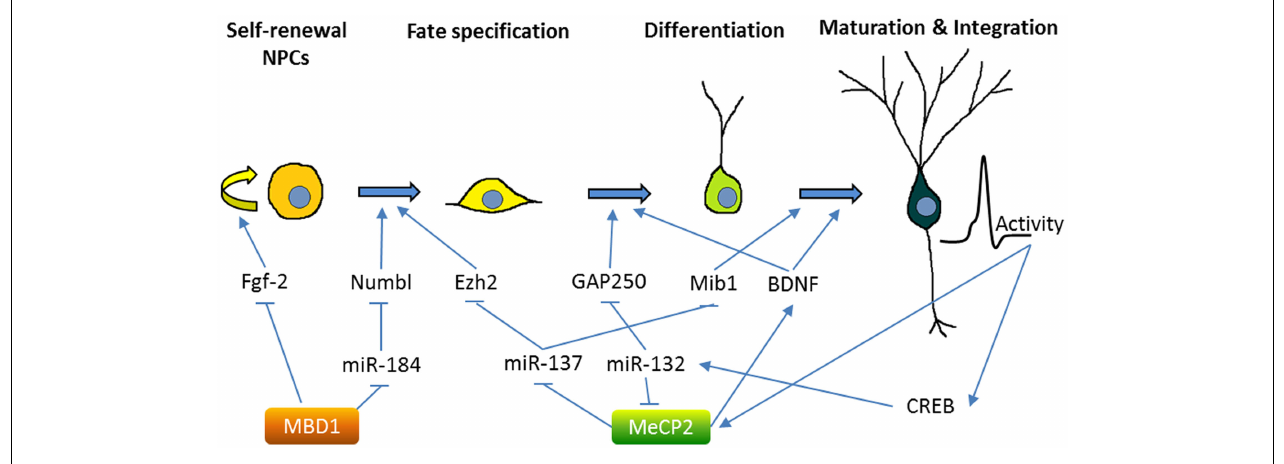
pathways (e.g., miR-184). MeCP2 plays important roles at multiple stages of neurogenesis from NSC fate specification to maturation and integration of new neurons. Similar to MBD1, MeCP2 is known to both directly regulate the expression of developmental genes (e.g., BDNF) and indirectly modulate gene expression through miRNA pathways (e.g., miR-137 and miR-132). On the other hand, MeCP2 is regulated by neuronal activity and at least in part through CREB-regulated miRNA (see text for